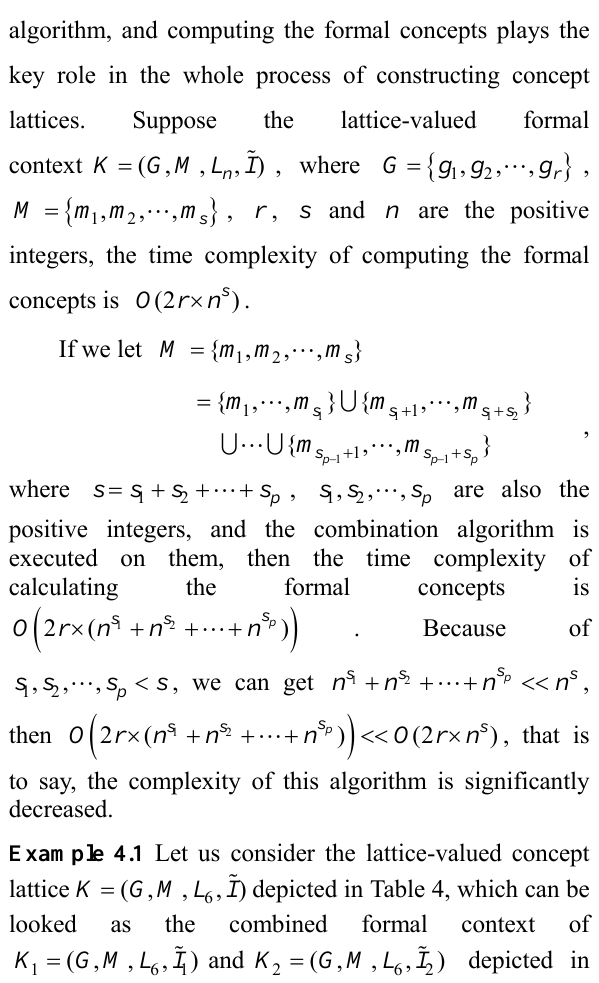
Fig. 3 Hasse diagram of